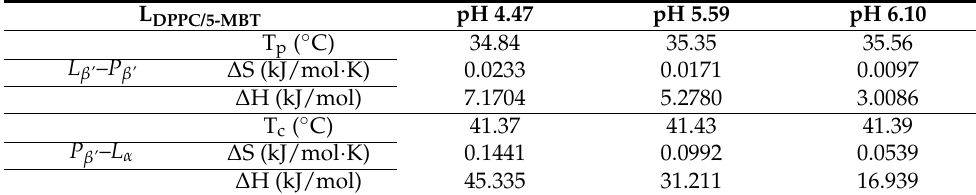
Table 4. Influence of buffer pH on the values of parameters ∆ H, ∆ S determined for the phospholipid pre-phase transition temperature (Tp) and the main phase transition (Tc) of phospholipids forming L DPPC/5-MBT